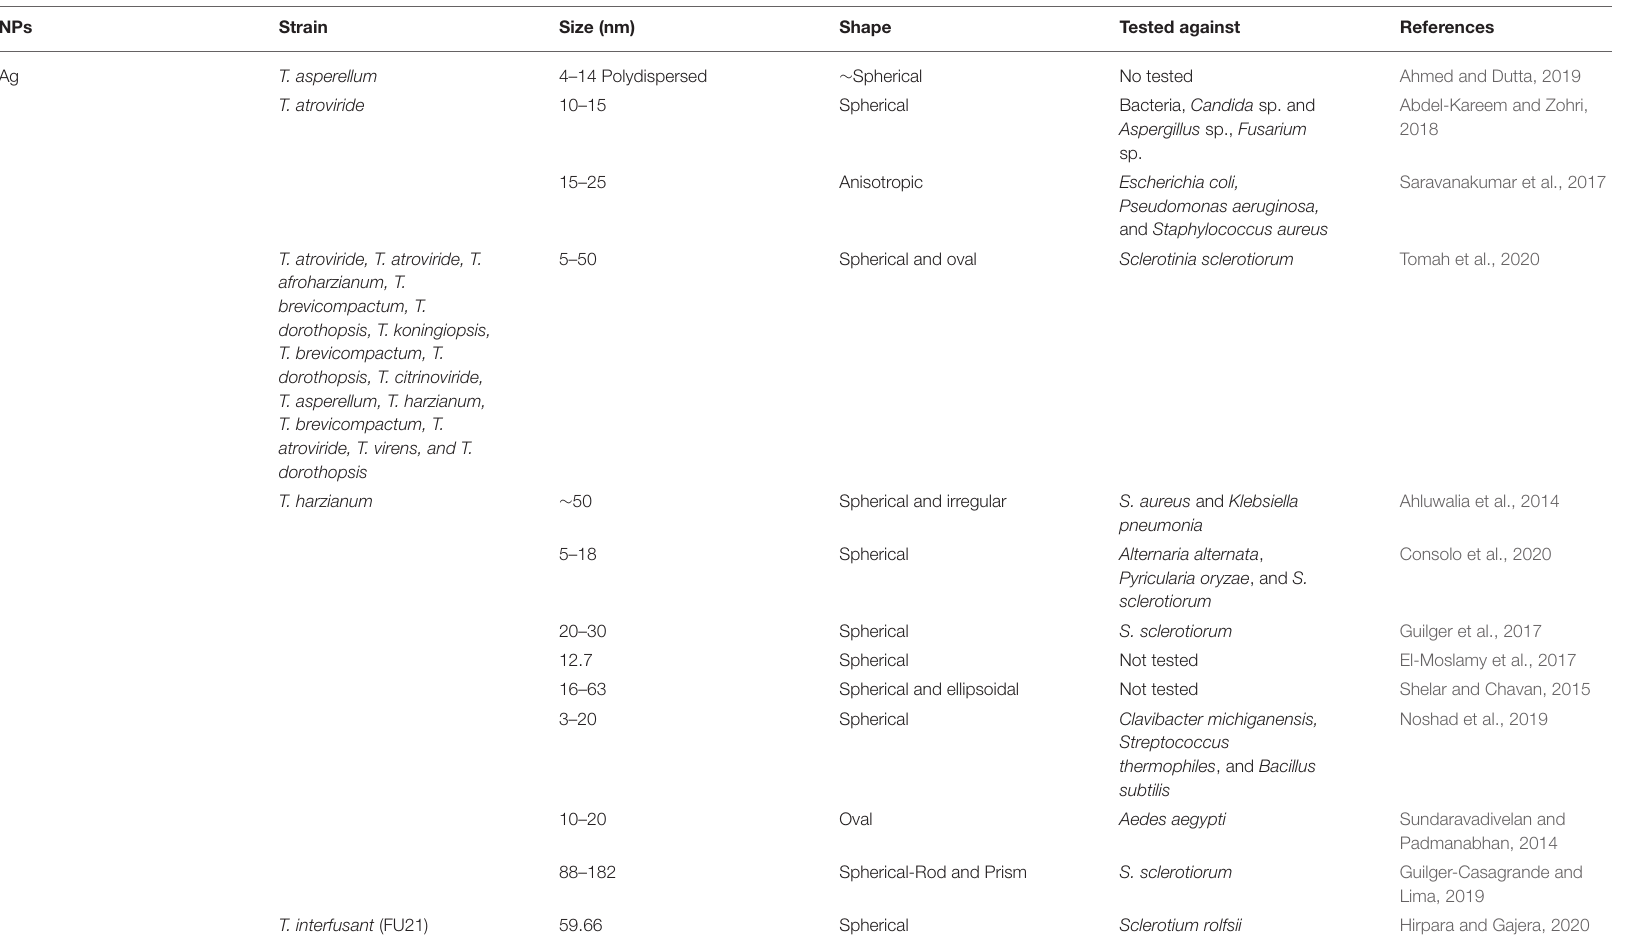
TABLE 1 | Nanoparticles (NPs) synthesized by Trichoderma .